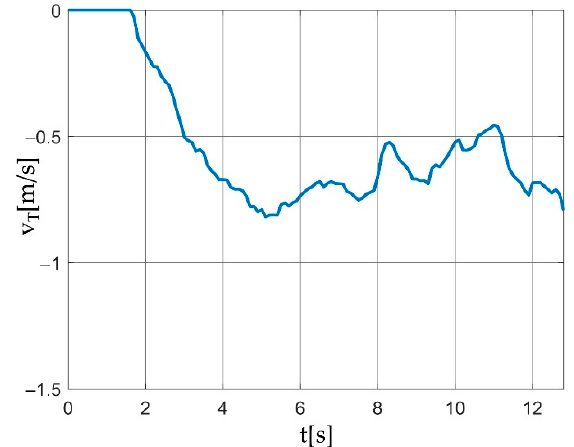
Figure 13. Robot characteristic point speed related to the retroreflector in the transformed coordi- nate system.